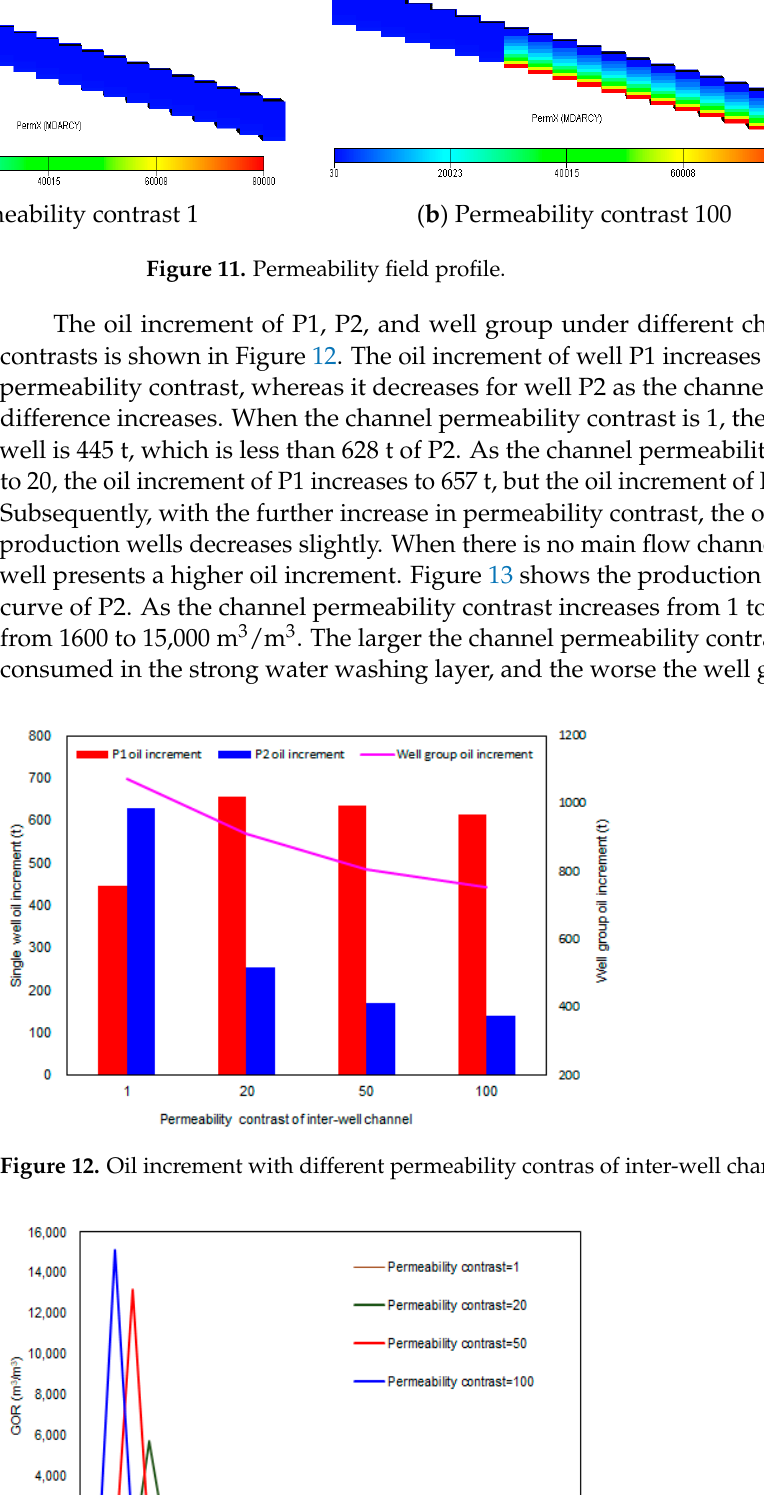
Figure 11. Permeability field profile.